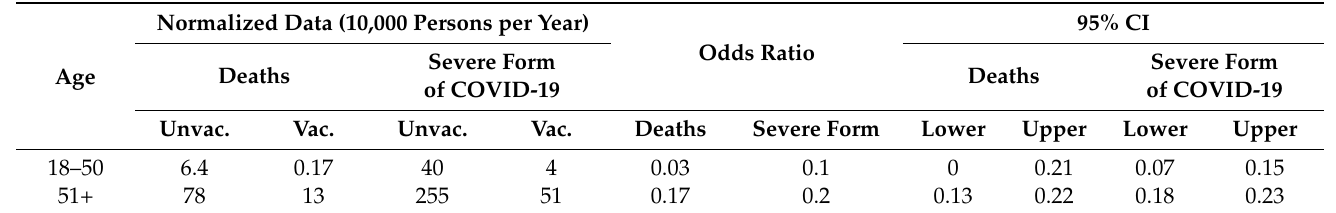
Table 2. Estimation of deaths and severe COVID-19 cases. Data obtained in Moscow in June